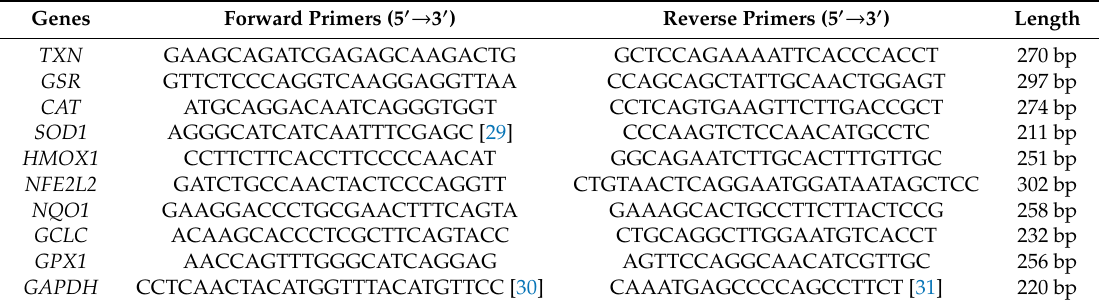
Table 1. Primer information for antioxidant-associated genes